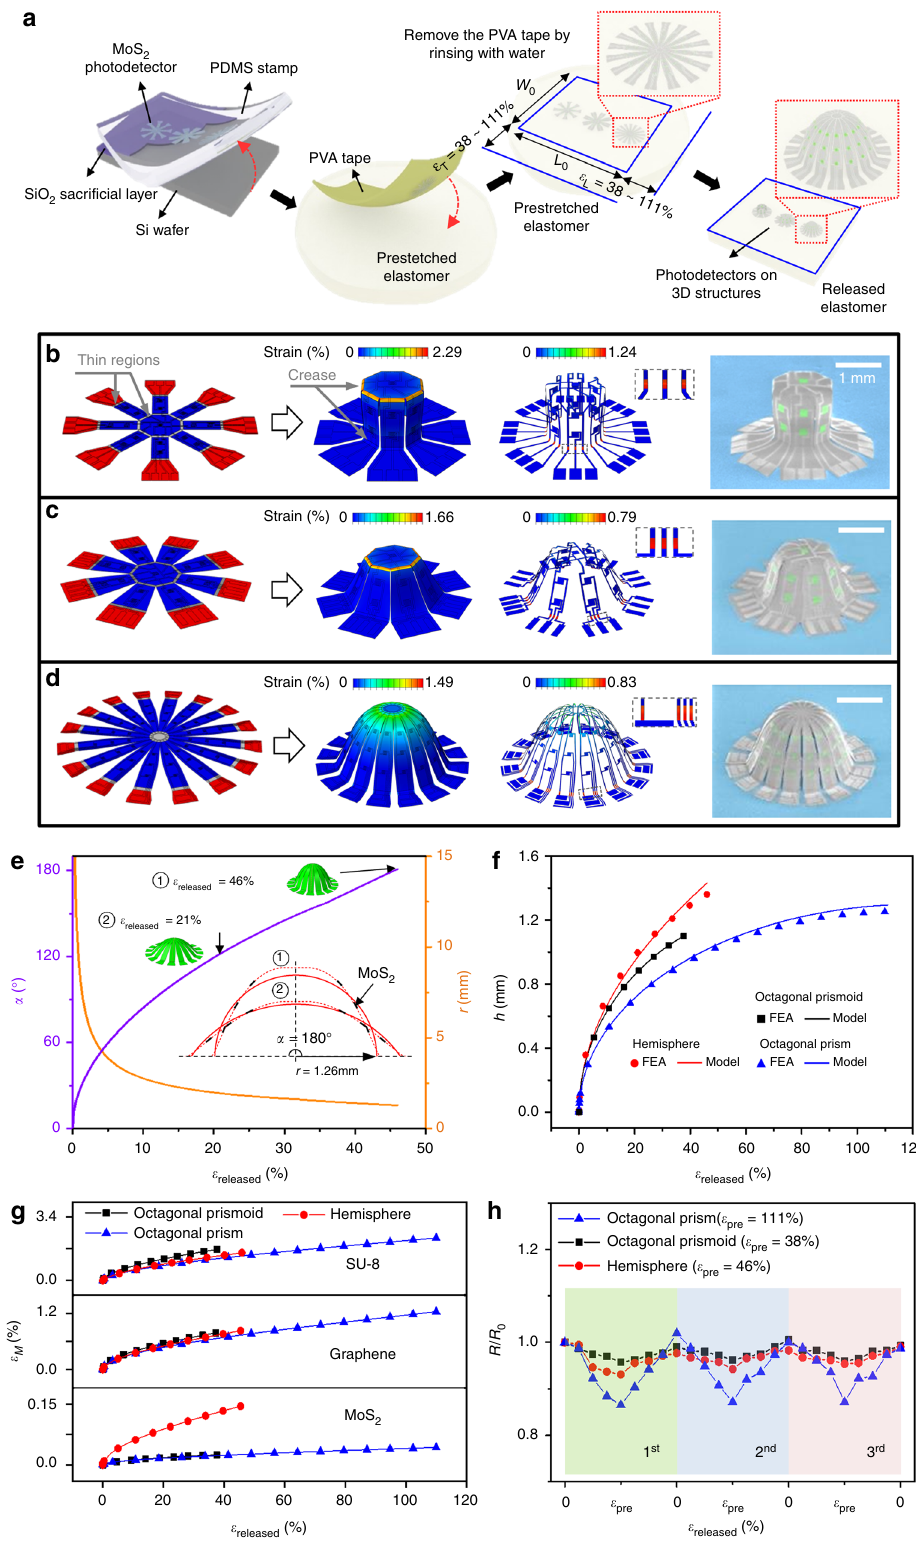
graphene and MoS 2 , separately shown in the mid-right parts of Fig. 1b – d, exhibit similar trends. The pre-strain values optimized by FEA experimentally yield 3D structures nearly identical to those predicted. The corresponding scanning electron micro- scopic (SEM) images are in Fig. 1b – d (right). The strain levels created in individual graphene, MoS 2 , and SU-8 layers of each 3D